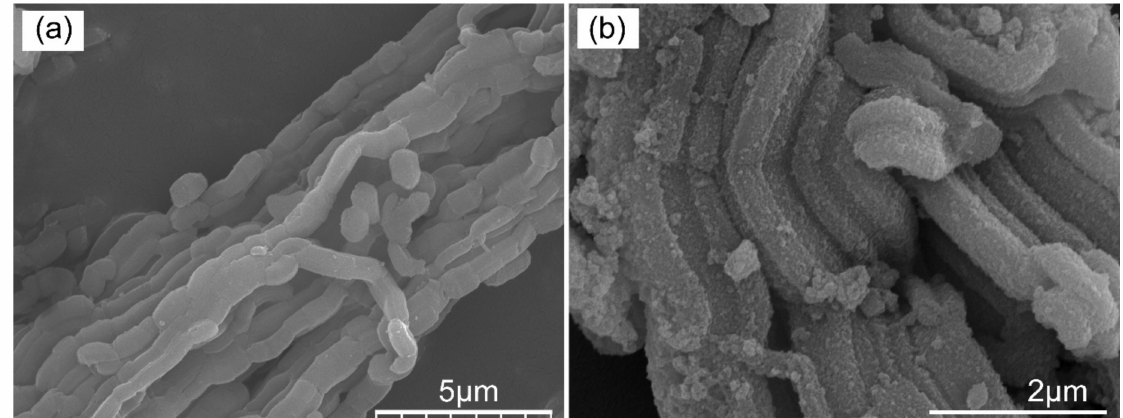
Figure 5. ( a ) SEM images of the pristine adsorbent and ( b ) adsorbed adsorbent.